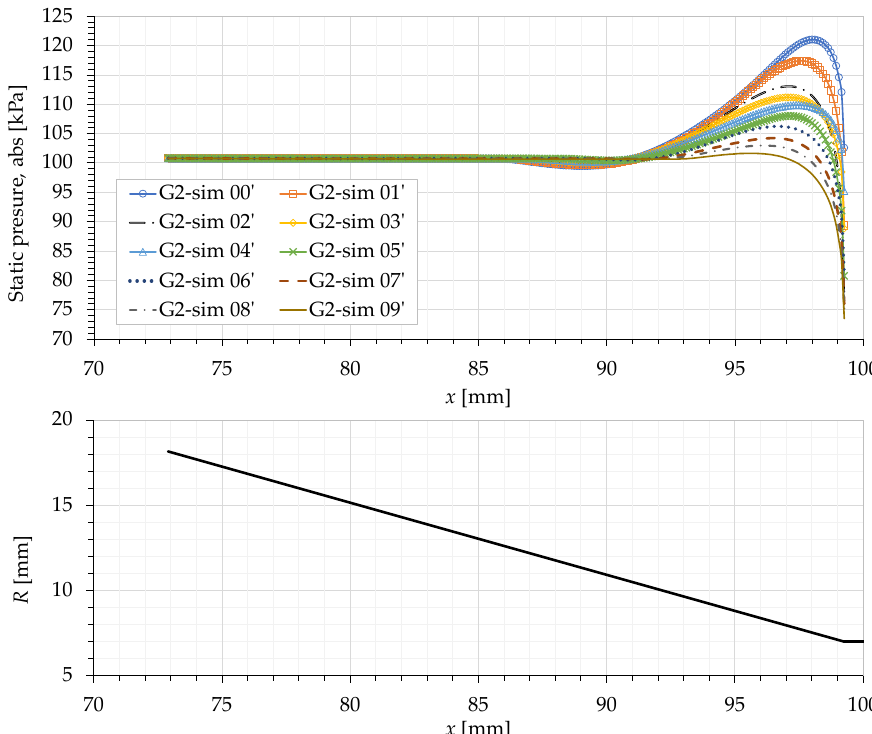
Figure 21. Pressure variation along the wall of the converging mixing section (72.9 ≤ x ≤ 99.259 mm) of ejector G2 (top) and the geometrical contour of the converging mixing section wall (bottom). The operating conditions of sim 00’ to 09’ can be seen in Table 5 (correspond to sim no. 0’ to 9’).